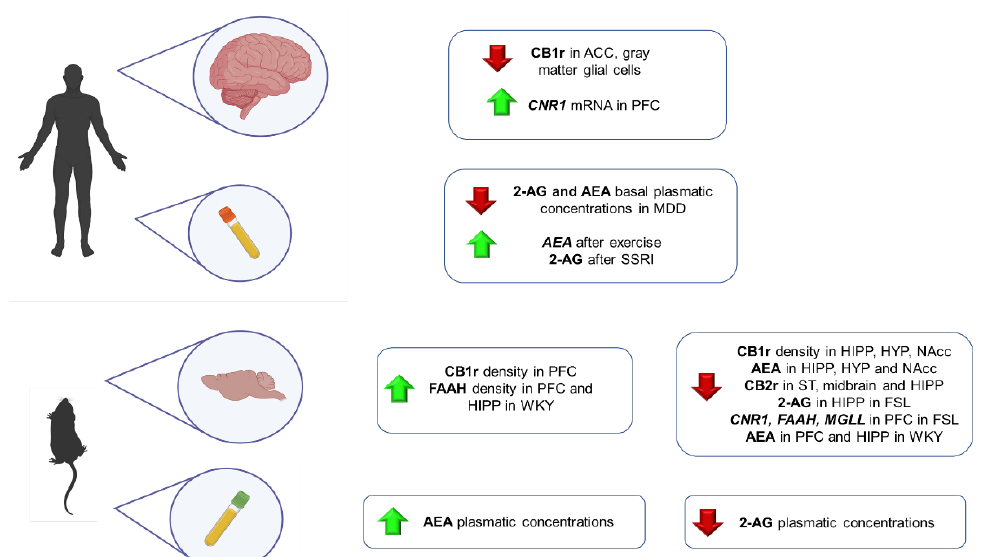
Figure 3. Main findings regarding the alterations of ECS components in animal models and patients with depression. 2-AG: 2-arachidonoylglycerol; ACC: anterior cingulate cortex; AEA: anandamide; CB1r: cannabinoid receptor 1; CNR1 : gene encoding CB1r; FAAH: gene encoding fatty acid amide hydrolase; FSL: Flinders Sensitive Line rats; HIPP: hippocampus; HYP: hypothalamus; MDD: major depressive disorder; MGLL: gene encoding MAGL; NAcc: nucleus accumbens; PFC: prefrontal cortex; SSRI: selective serotonin reuptake inhibitors; ST: striatum; WKY: Wistar Kyoto rats.